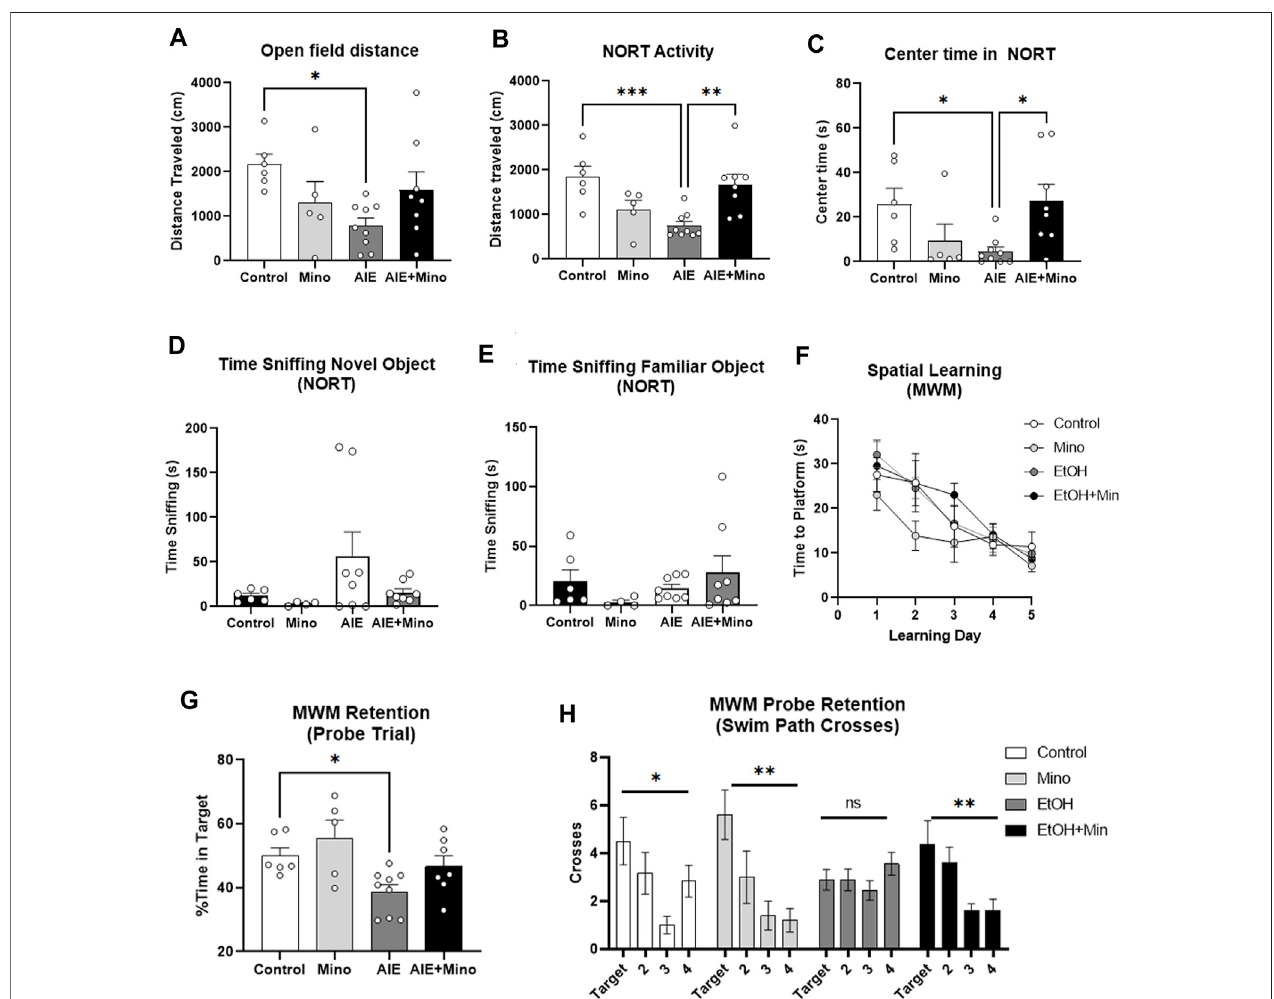
FIGURE5| AIEworsensAD-associatedactivityandmemoryde fi citsinadultfemale3xTg-ADmice(P200)withpreventionbyminocycline. (A,B) Locomotoractivity AIE caused a reduction in locomotor activity in adulthood as measured by (A) 1 h in the open fi eld that was blunted by minocycline (63% reduction, 1-way ANOVA treatmenteffectF 3,24 =3.353, p =0.036,* p < 0.05,Sidak ’ smultiplecomparison test),and (B) 10 minintheopen fi eldduring habituationforthenovelobjectrecognition test (NORT) that was prevented by minocycline; 60% reduction, F 3,24 = 7.366, p = 0.001, **p < 0.01, *** p < 0.001 Sidak ’ s post-test. (C) Center time in the open fi eld. AIE reduced time spent in thecenter ofanopen fi eld withpreventionby minocycline asmeasured by10 min inthe open fi eldduring habituationfor theNORT;82% reduction, F 3,24 =3.9, p = 0.02, *p < 0.01Sidak ’ s test. (D, E) NovelObject RecognitionTest (NORT). (D) Atrend toward an increase in time snif fi ngthe novel object was seenintheAIEtreatmentgroup, p = 0.07. (E) Nosigni fi cantdifferencesbetweengroupswereobservedintime snif fi ngthefamiliarobjectduringtheNORT. (F,H) Morris WaterMaze(MWM) learningand retention (F) AIEhadnoeffectonspatial learningintheMWM.AIE,however,causedanimpaired memoryretentionthatwasprevented by minocycline as measured during the probe trial with (G) less time spent in the correct quadrant; 33% reduction, F 3,23 = 4.7, p = 0.01, *p < 0.05 Sidak ’ s test, and (H) fewer swim path crosses over the target location. 1-way ANOVA treatment effect * p < 0.05, ** p < 0.01. N = 6 Control, 5 Mino, 8 AIE, 8 AIE + Mino.